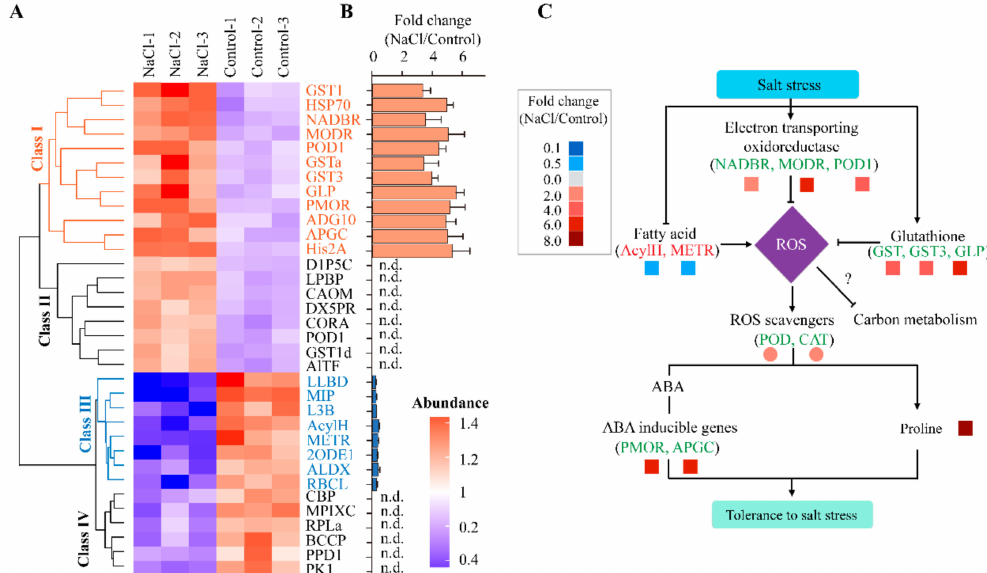
Figure 6. Global protein expression levels in alfalfa in response to salt stress. ( A ) Hierarchical clustering heatmap representing relative expression of the top 10% di ff erentially abundant proteins (DAPs) between 200 mM NaCl treatment and control. Hierarchical clustering based on the abundant levels of protein identified was performed using Gene Cluster 3.0 software with the Euclidean distance similarity metric and linkage method. The resulting clusters were visualized using Java TreeView software. The fonts with blue color were further tested with qPCR. ( B ) Relative gene expression of DAPs determined by qPCR analysis. ( C ) A proposed model representing the regulation of the ROS scavenging system as a means of tolerance to salt stress. Symbol "?" represents unknown pathways. The fold change among these proteins in NaCl relative to control was depicted using di ff erent gradient colors. The expressions of values for di ff erent proteins were based on qPCR or physiological